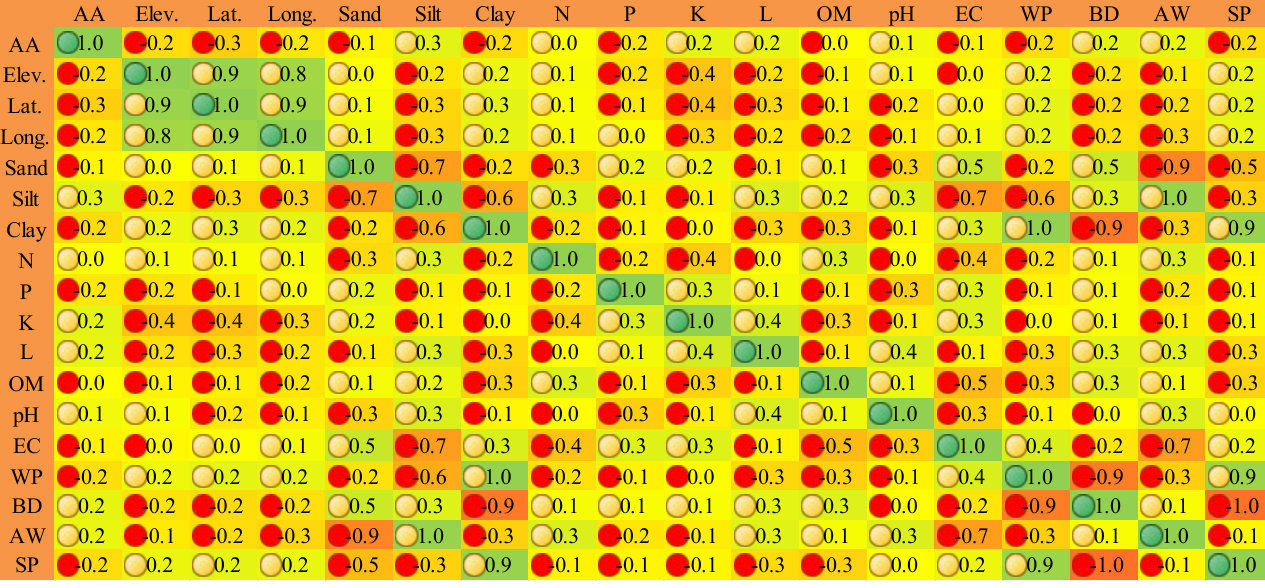
Figure 6. Correlation heat map showing the relationship among the environmental variables of mining and non-mining sites. Note: Legends are same as that of Table 2.